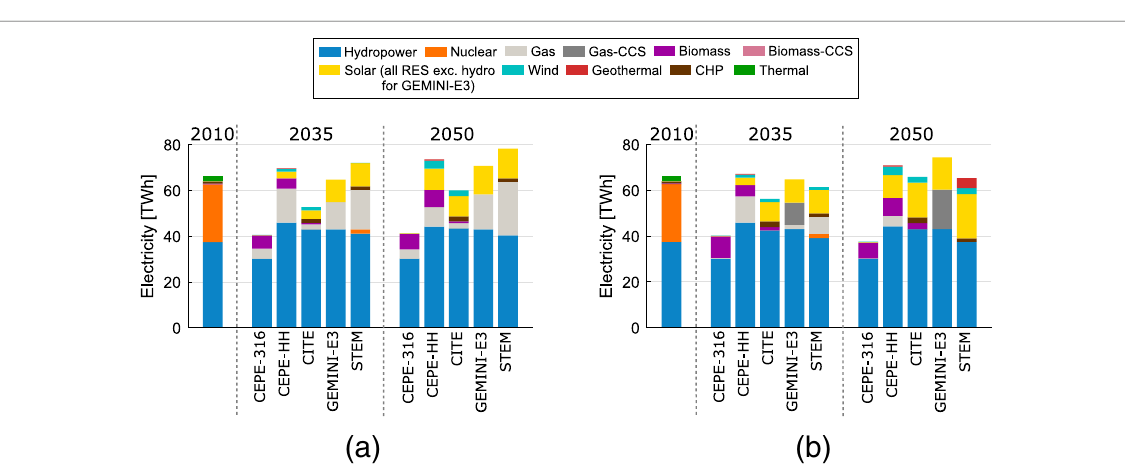
Fig. 4 Electricity generation. Note that the GEMINI-E3 model has one renewable technology that aggregates all renewables other than hydro; hence, the yellow color represents all renewables (excluding hydro). a BAU. b